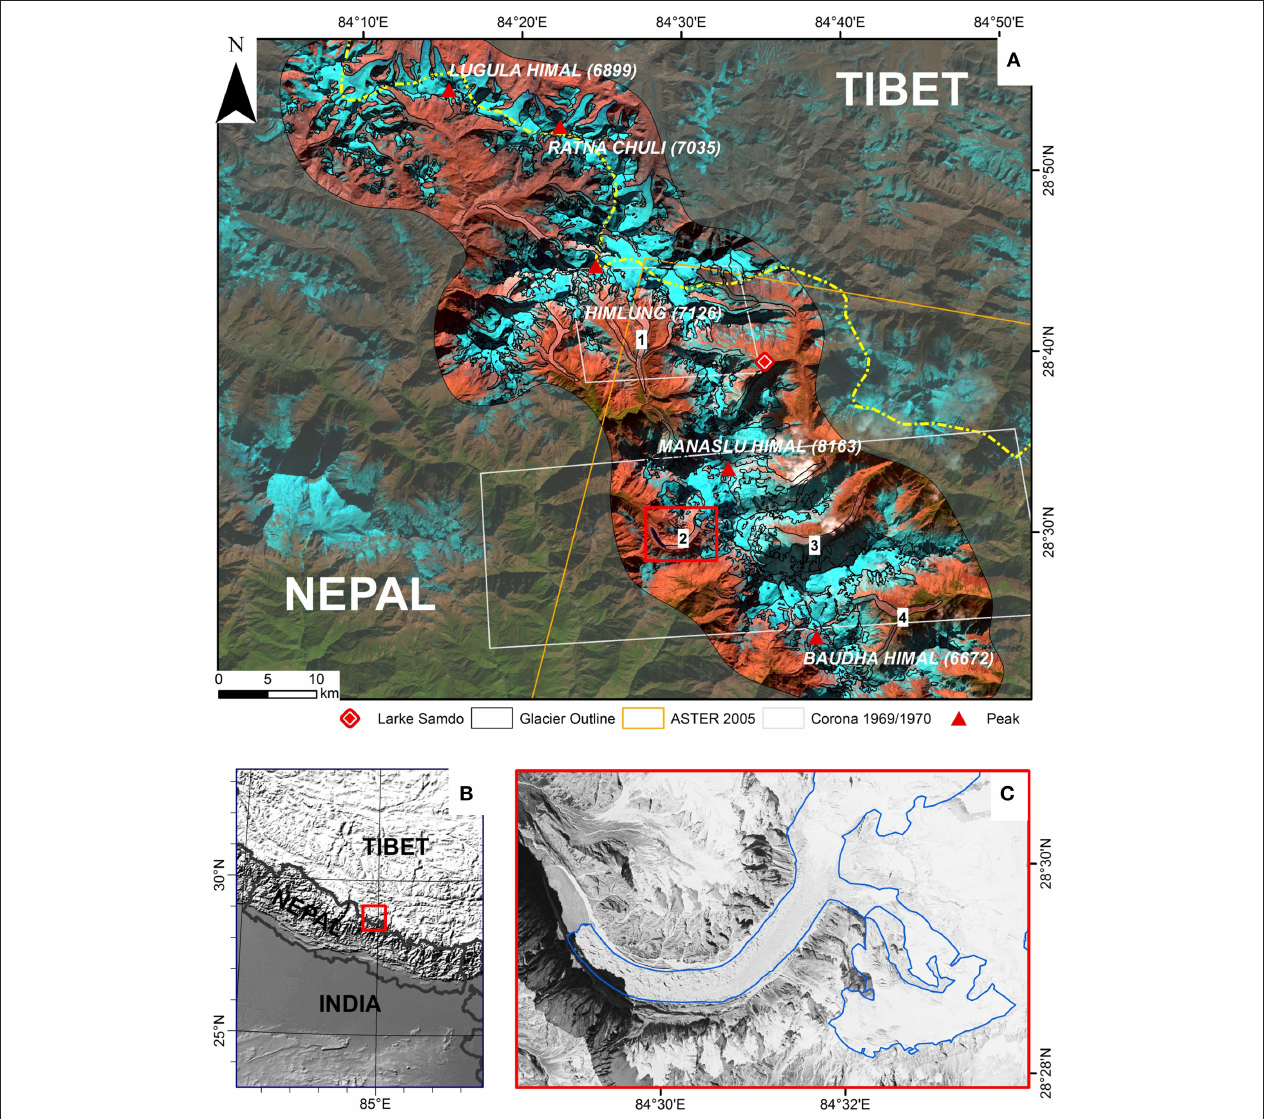
FIGURE 1 | (A) Location of the glaciers studied (outlines derived from Robson et al., 2015) within the Manaslu Region (28 ◦ N, 84 ◦ E), and (B) the location of the Manaslu Region within Nepal. Thulagi Glacier (C) previously terminated in Dona Lake (shown on the 1970 Corona image). Larke Samdo weather station is shown as a red diamond outline. Four glaciers that are referred to in the text in more detail are shown on (A) : 1—Ponkar Glacier, 2—Thulagi Glacier, 3—Hinang Glacier, 4—Himal Chuli Glacier. All the glaciers within the emphasized image on (A) were covered by the SETSM and SRTM DEMs. The coverage of the ASTER and Corona datasets are shown in orange and gray in (A) . The boundary between the northern group of glaciers and the southern group of glaciers is shown as a yellow dashed line. Background image: Landsat 8 (26th December 2013). Hillshade in (C) is from naturalearthdata.com.